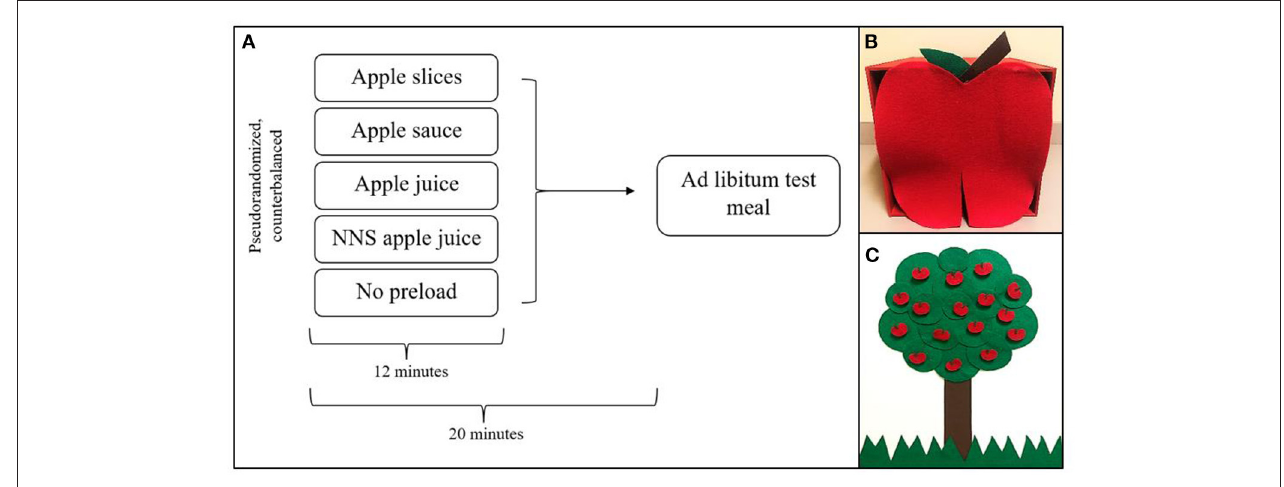
FIGURE 2 | Overview of preload protocol (A) , child-friendly box to mask preload volume (B) , and game board to encourage children to finish preloads (C) .